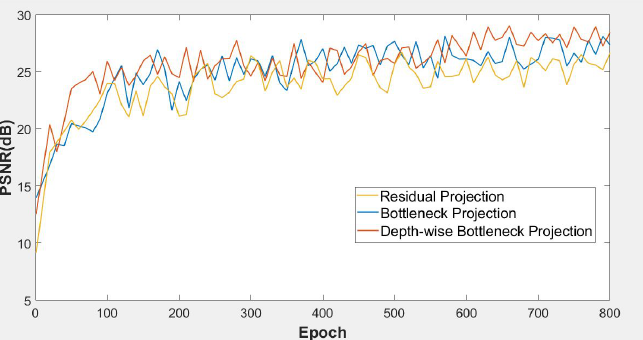
Figure 8. Average PSNR (dB) per epoch for training our model with different projection approaches on the DIV2K